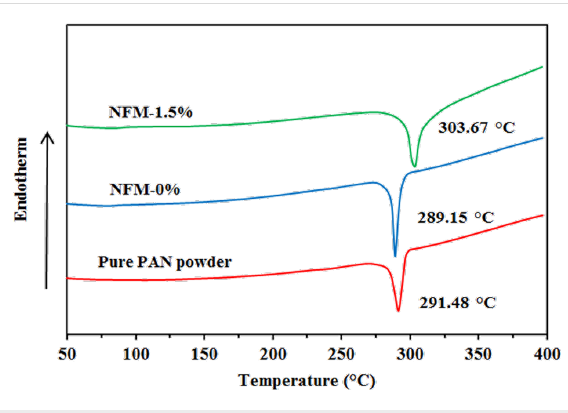
Figure 6: DSC thermograms for pure PAN powder, NFM-0% and NFM-1.5%.